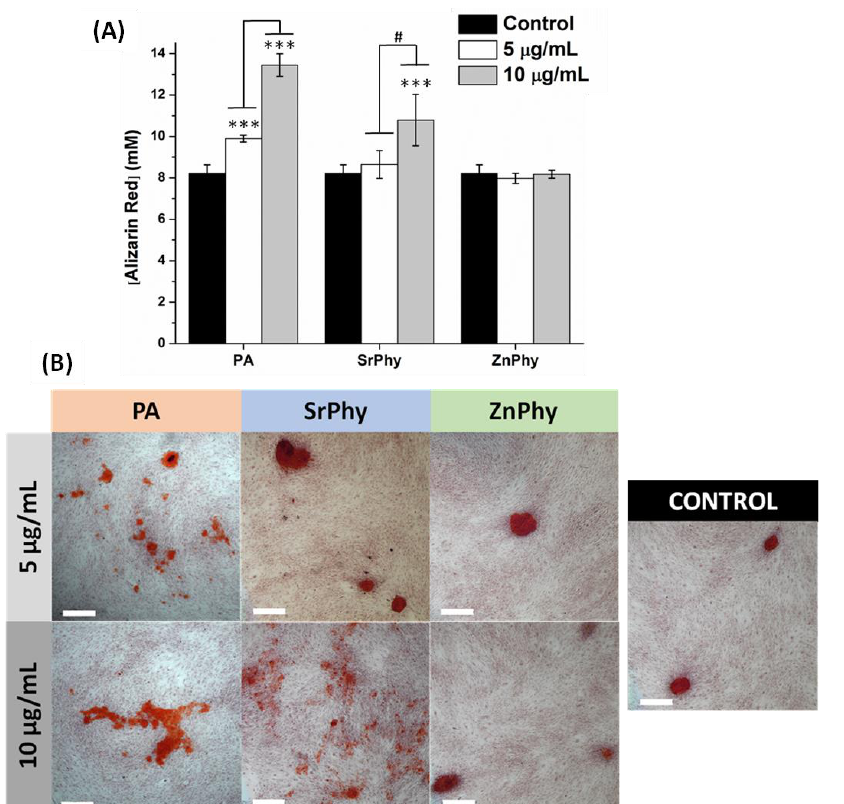
Figure 8. ( A ) Quantitative determination of extracellular matrix mineralization with hMSCs cultures in the presence of PA, SrPhy or ZnPhy at 5 and 10 µg/mL after 21 days. The results for each concentration were statistically compared relative to the control group (osteogenic-DMEM) (ANOVA, *** p < 0.001, Tukey’s test), and between the two concentrations tested in each compound (ANOVA, # p < 0.001, Tukey’s test). The results are represented as the mean AzR concentration (mM) ± SD ( n = 3). ( B ) Representative microscopic images (4 × ) of the AzR staining after 21 days of culture. Scale bars correspond to 500 µ